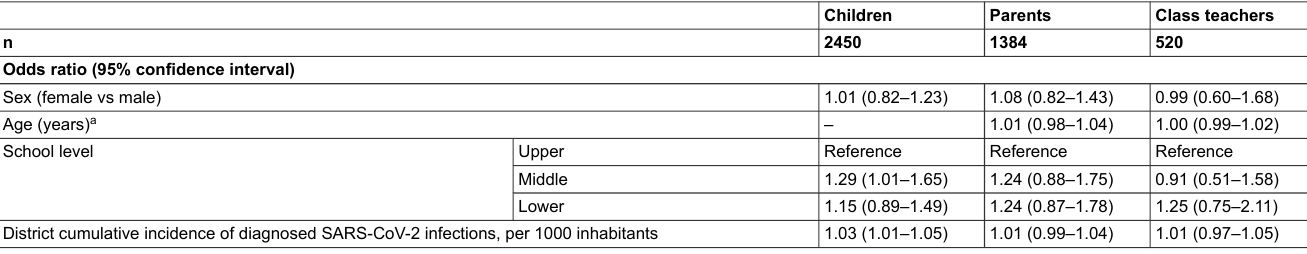
Table S3: Multivariable logistic regression models for individual children, parents’ and class teachers’ serological results in March-April 2021.